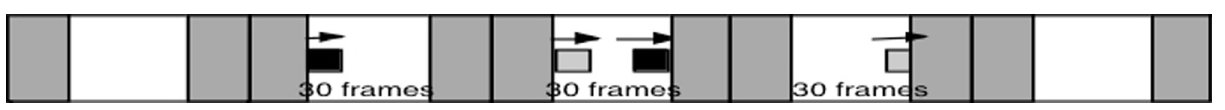
Frontiers in Psychology | Cognitive